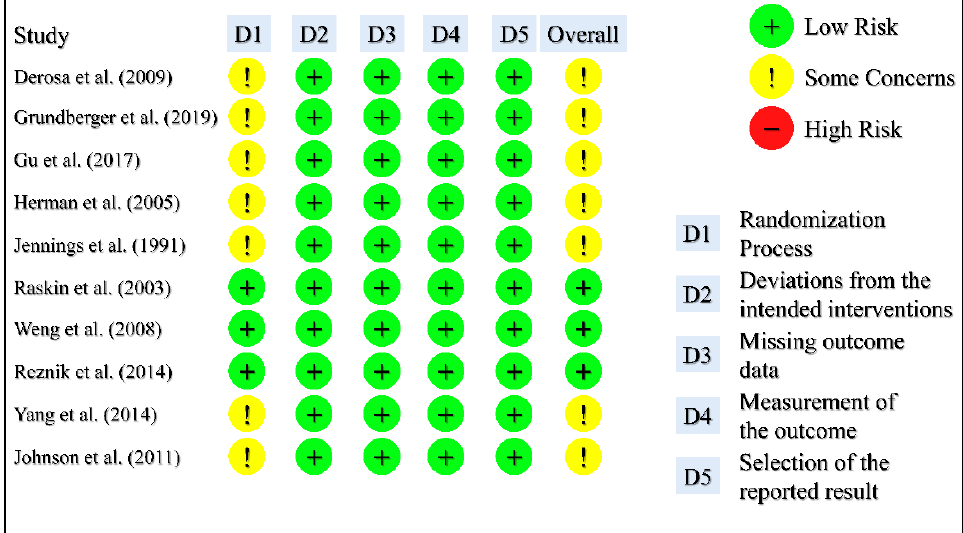
Figure 2. Risk of Bias Assessment Traffic Light Illustration for Studies with Parallel Design.